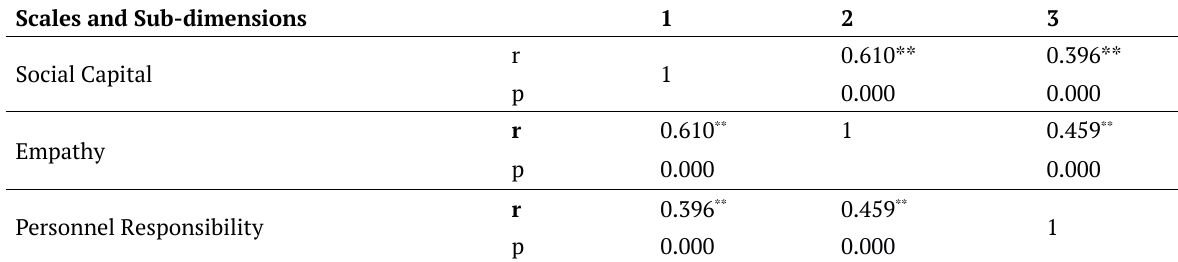
Table 3. Relationships Of Social Capital, Empathy and Personnel Responsibility Scales Scales and Sub-dimensions